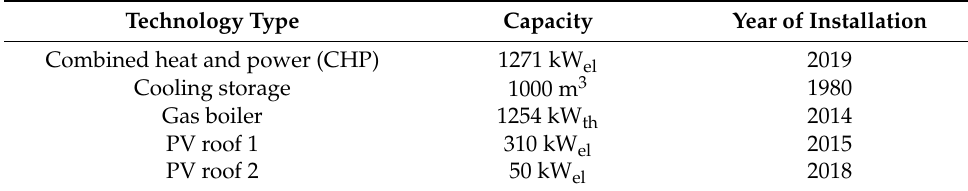
Table 2. Preinstalled technologies.